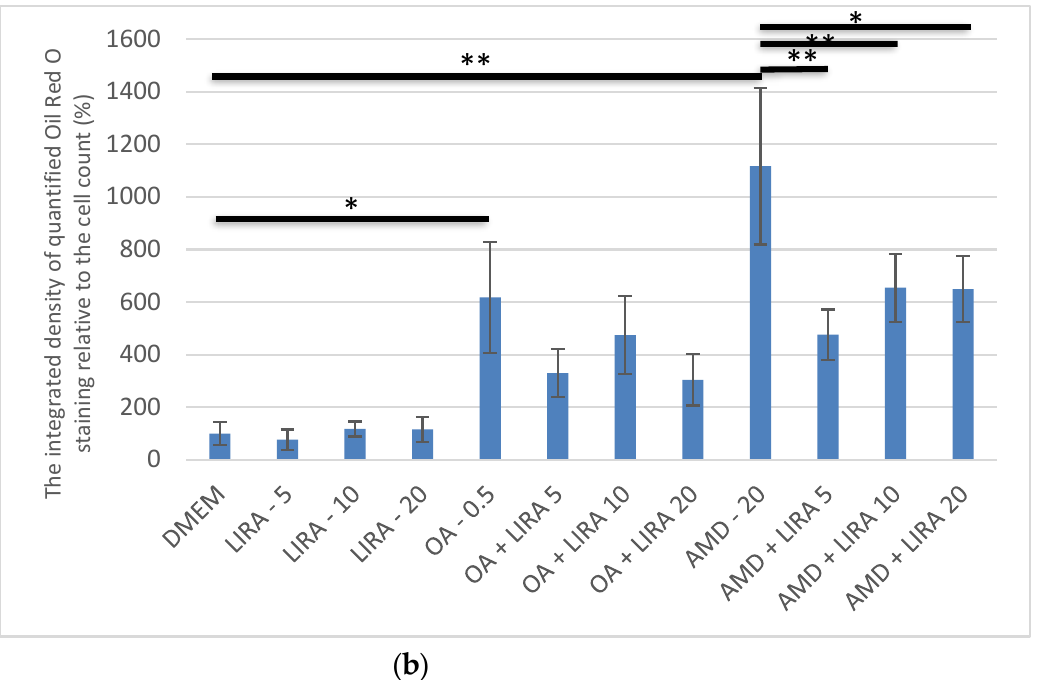
Figure 3. Quantification and visualization of the lipid accumulation with Oil-Red O-dye. ( a ) Visual- ization of lipid accumulation with Oil-Red-O dye. Lipid accumulation in Huh7 cells was visualized with Oil-Red-O dye, while DAPI (blue color) was used to stain nuclei. ( A )—DMEM (negative control), ( B )—5 nM LIRA, ( C )—10 nM LIRA, ( D )—20 nM LIRA, ( E )—0.5 mM OA, ( F )—0.5 mM OA and 5 nM LIRA, ( G )—0.5 mM OA and 10 nM LIRA, ( H )—0.5 mM OA and 20 nM LIRA, ( I )—20 µ M AMD, ( J )—20 µ M AMD and 5 nM LIRA, ( K )—20 µ M AMD and 10 nM LIRA, ( L )—20 µ M AMD and 20 nM LIRA. Size bar represents 10 µ m. Dulbecco’s modified Eagle’s medium (DMEM), liraglu- tide (LIRA/nM), oleic acid (OA/mM), amiodarone (AMD/ µ M). ( b ) Levels of lipids stained with Oil-Red-O dye in the Huh7 cells treated with OA, AMD, and LIRA. Data represent the integrated density of red color relative to the cell count. A higher number equals a more intense stain. Results are shown as a percentage relative to the negative control. One way ANOVA F (11, 130) = 66.2; p = 2.54 × 10 − 45 ; Mann-Whitney U (Bonferroni-corrected p -value). Bars assigned with asterisks are statistically significantly different (* p < 0.05, ** p < 0.01). The data are shown as the means ± SD (standard deviation) from at least three biological replicates. Dulbecco’s modified Eagle’s medium (DMEM), liraglutide (LIRA/nM), oleic acid (OA/mM), amiodarone (AMD/ µ M).